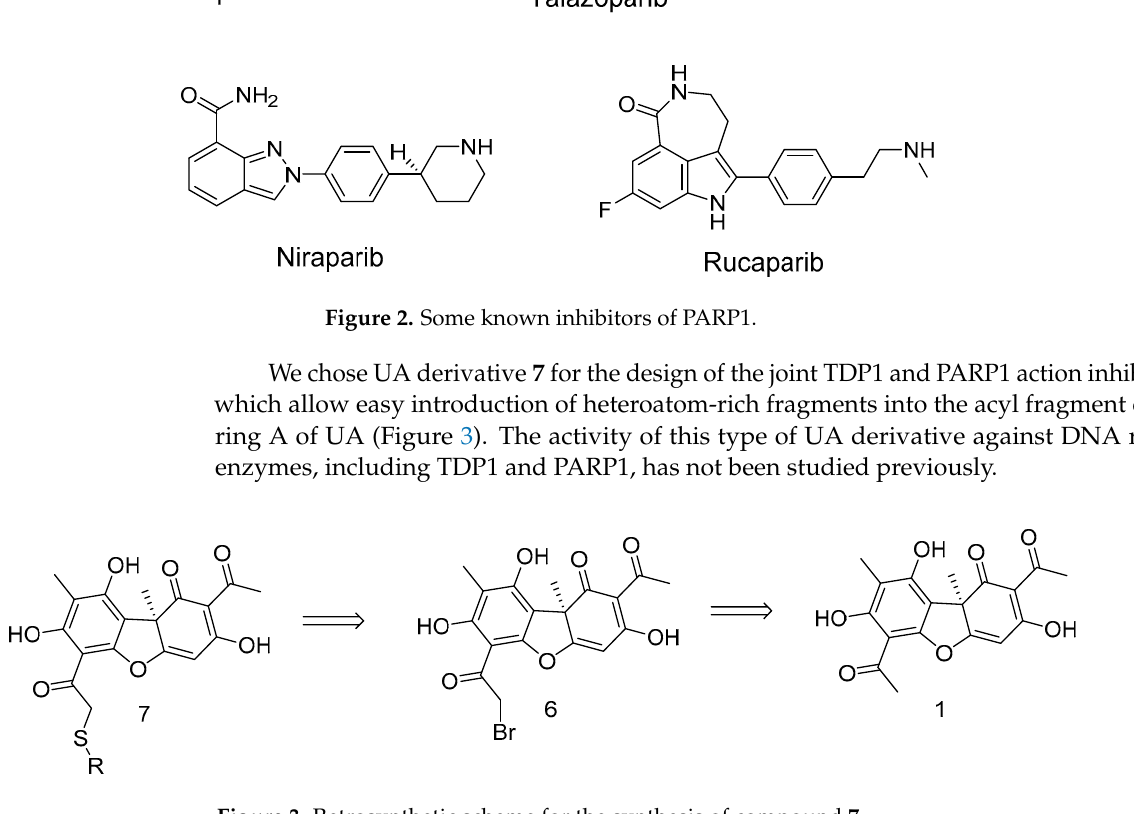
Figure 3. Retrosynthetic scheme for the synthesis of compound 7 .